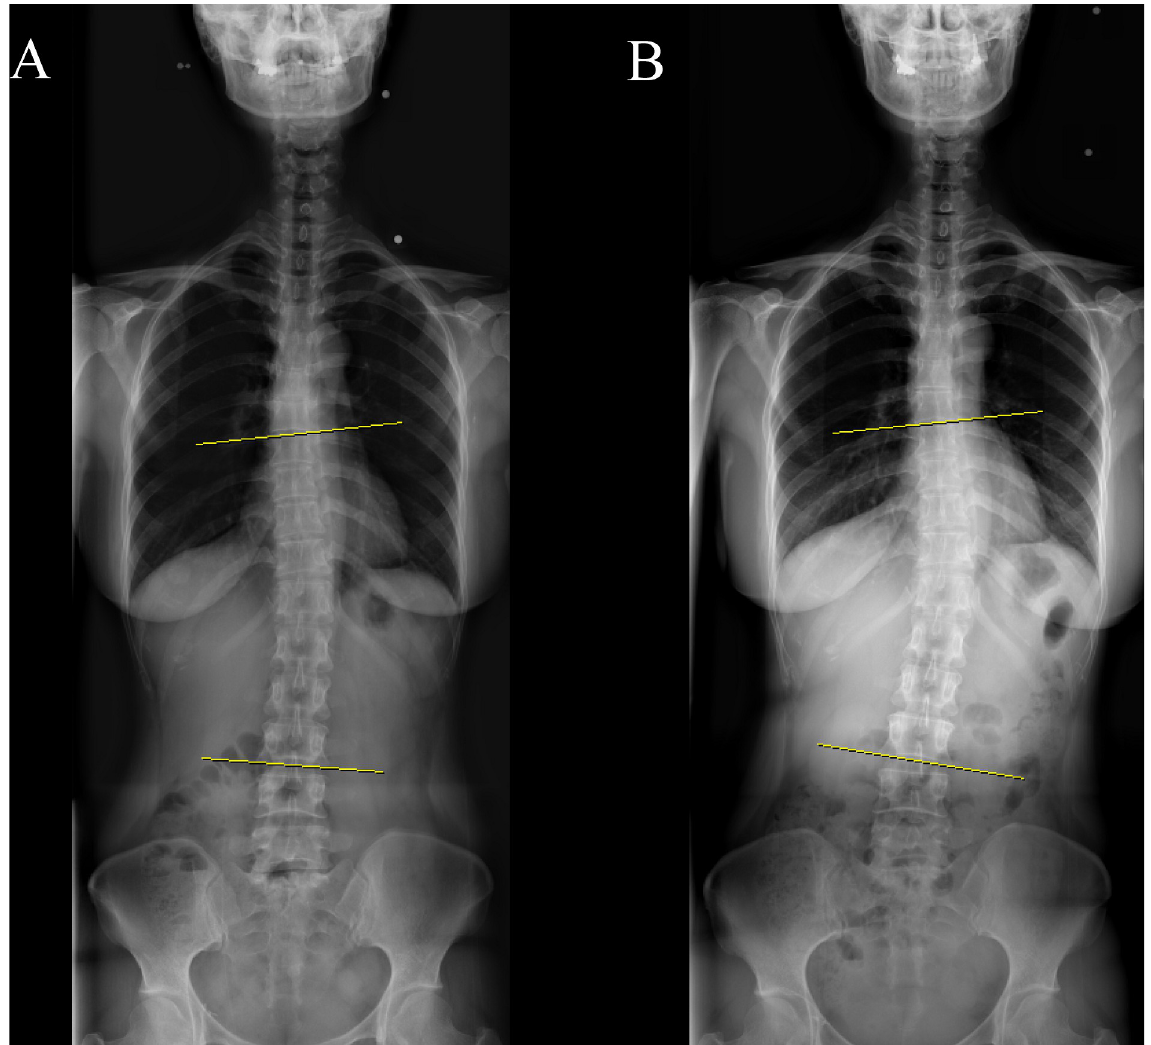
Fig 3. Demonstration of Cobb angle on whole-spine radiograph in one patient with a significant change in spinal curve; (A) Initial radiograph (B) Follow-up radiograph.